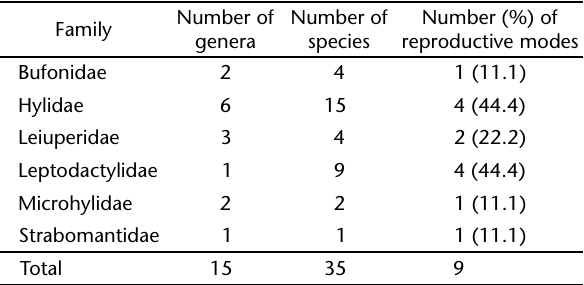
Table I. Diversity of reproductive modes recorded per anuran family at the Tanguro farm in the Brazilian state of Mato Grosso. Number of Number of Number (%) of Family genera species reproductive